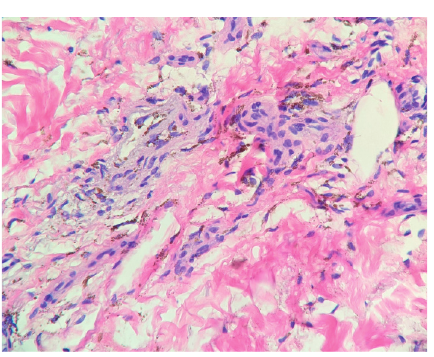
Figure 5: High-power magnification displays coarse brown pig- mented cytoplasmic granules within the dermal macrophages (400x; hematoxylin and eosin